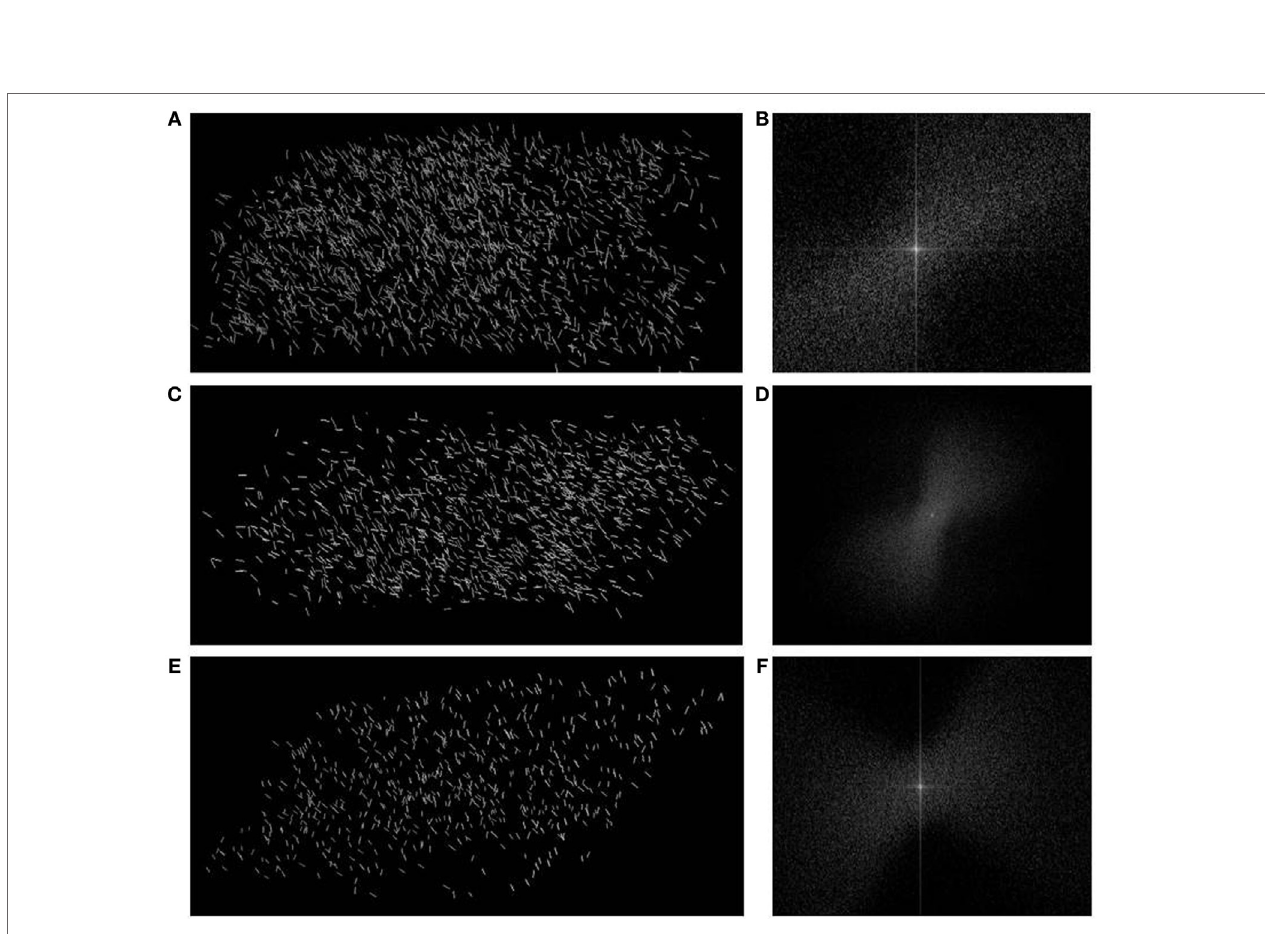
FigUre 10 | Vector orientations of the 3-N planar nodes from specimen P1, P2, P3 represented in the right part of the figure (a,c,e) and the FFT analyses of images are represented in the left side (B,D,F) .